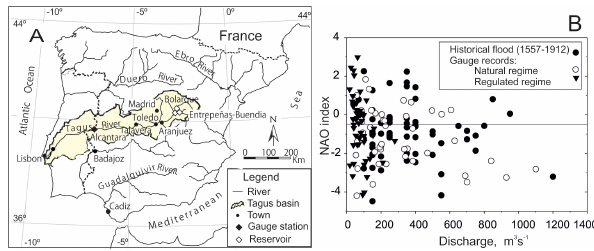
Figure 1. The Tagus River basin in the Iberian Peninsula. (a) Lo- cation of the historical and instrumental records used; (b) rela- tionship between the annual flood peak discharge at Aranjuez and the corresponding month value of the NAO index. Discharges over 400m 3 s − 1 are in most cases related to a negative NAO